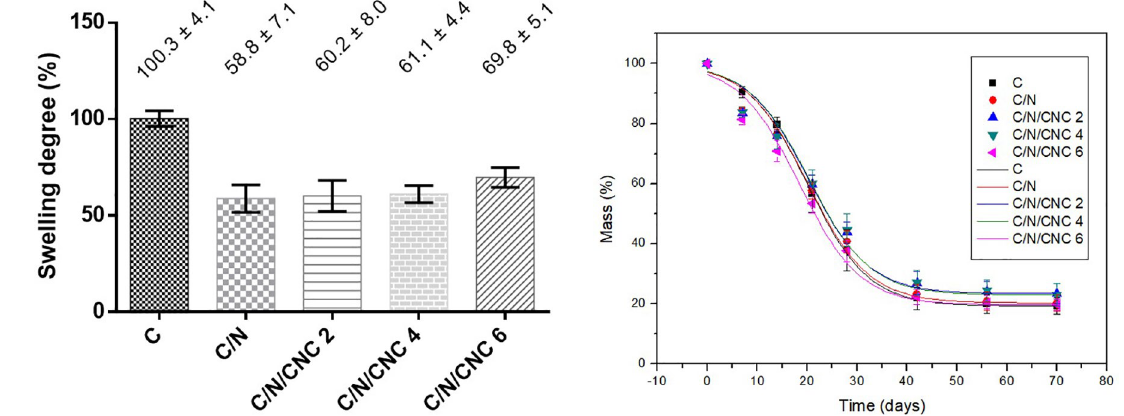
Figure 9. In vitro degradation curve of